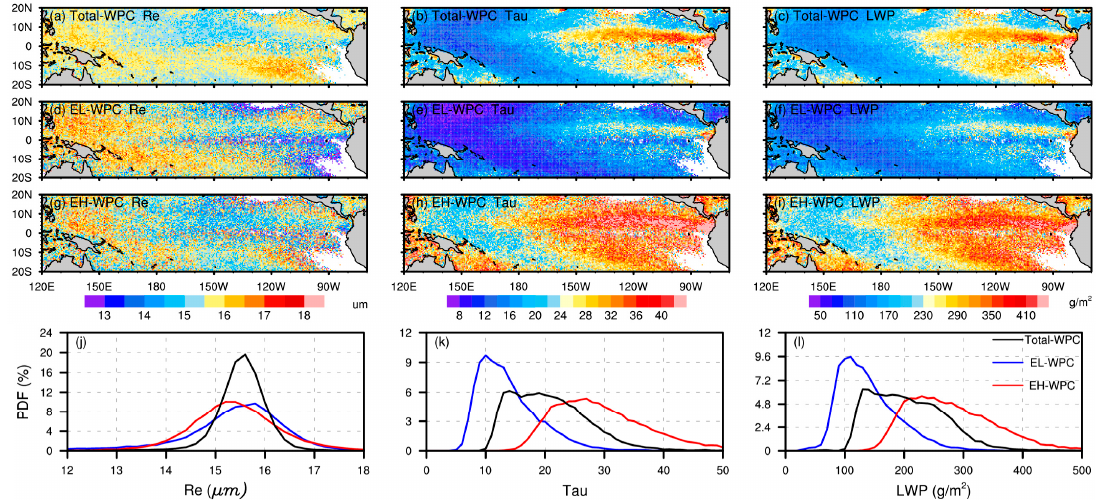
Figure 5. Distribution of ( left ) cloud effective radius (Re), ( middle ) cloud optical depth (Tau) and ( right ) liquid water path (LWP) for ( a – c ) total, ( d – f ) EL-WPC and ( g – i ) EH-WPC, along with ( j – l ) their probability distribution functions.